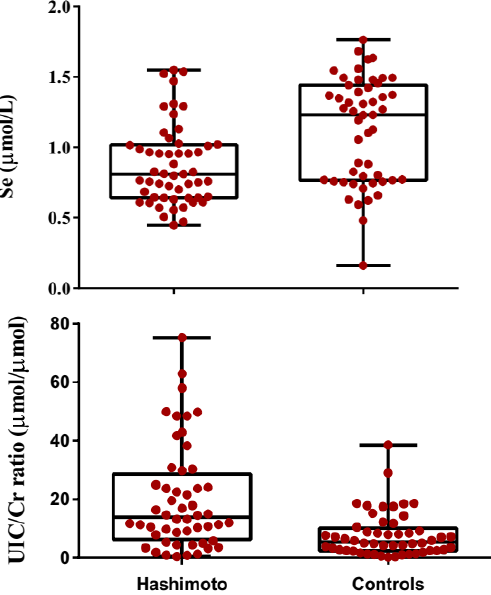
Figure 2. Box and whisker plots showing the selenium contents and UIC / Cr in HT patients and controls. The box describes first, second (median) and third quartiles. The whisker length represents minimum to maximum range. Each dot represents a single participant.